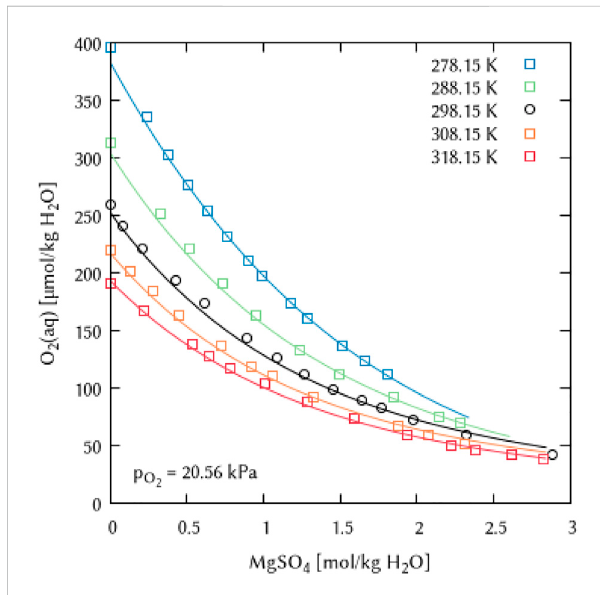
FIGURE 21 Modelling of the O 2 solubility in magnesium sulfate solution as a function of temperature and MgSO 4 concentration. [Points: Experimental data from ○ Millero et al. (2002a) and □ Millero et al. (2002b), Lines: this work].